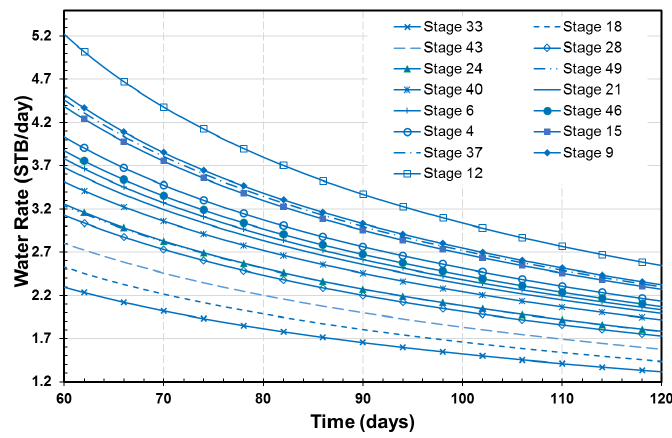
Figure 14. Stage-by-stage water production rate forecast for the 15 stages in Tables 5 and 6. The legend is arranged to correspond with the well performance ranking. Stage 12 has the greatest water production, while Stages 18 and 33 have the least.